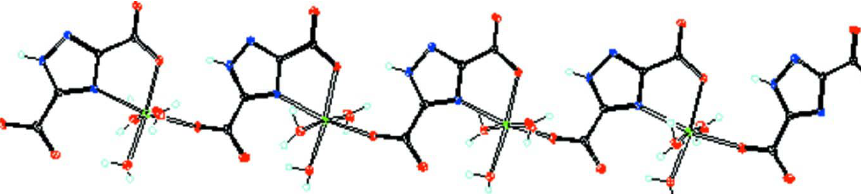
Local coordination environment of the title compound with 30% thermal ellipsoids. Symmetry code: a: x , -1/2 - y , -1/2 + z .